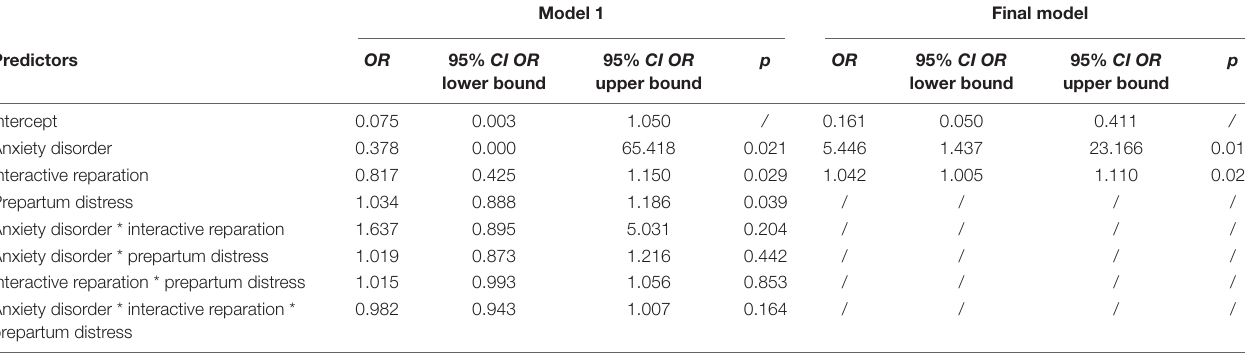
TABLE 2 | First and final generalized binomial regression models on infant attachment out of hierarchical backward procedure.